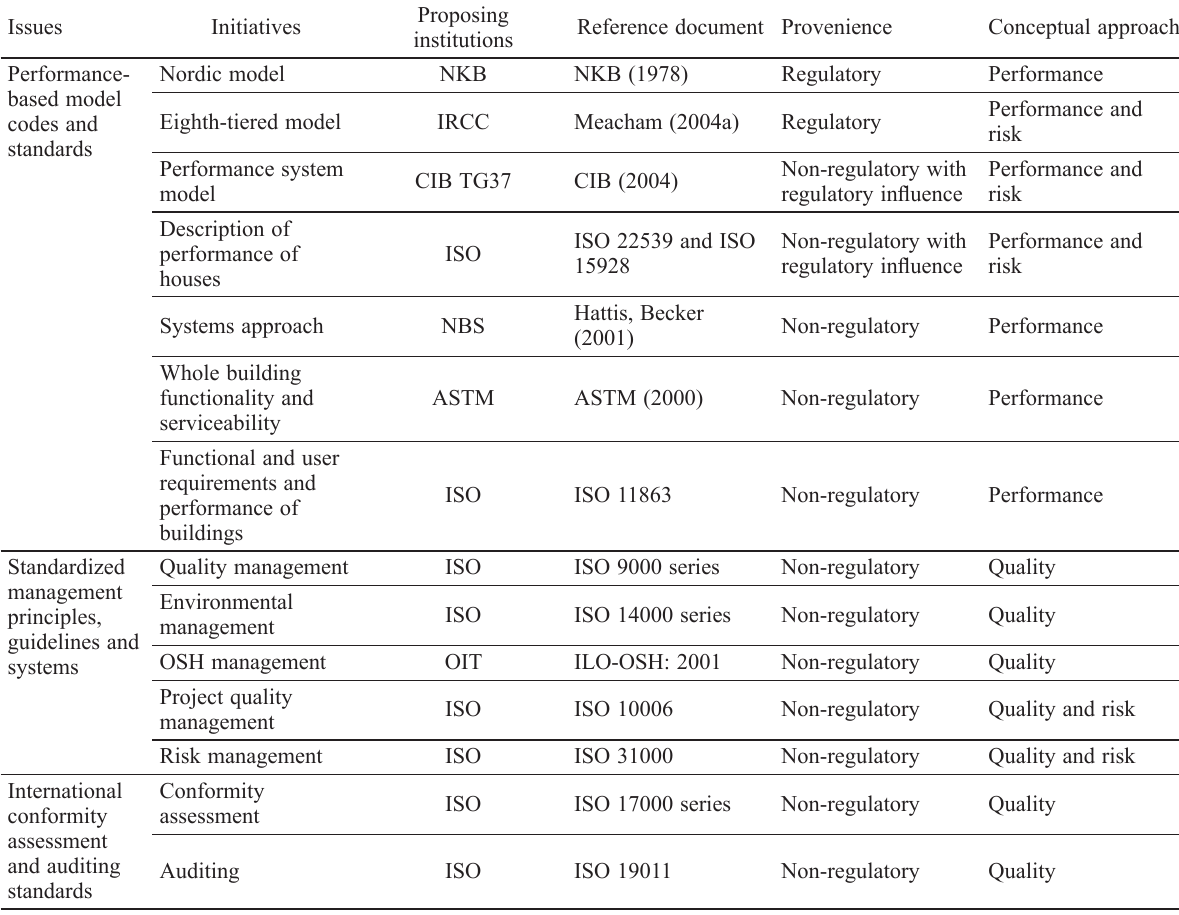
Table 1. Issues covered by the authors in the 1960–2000 literature